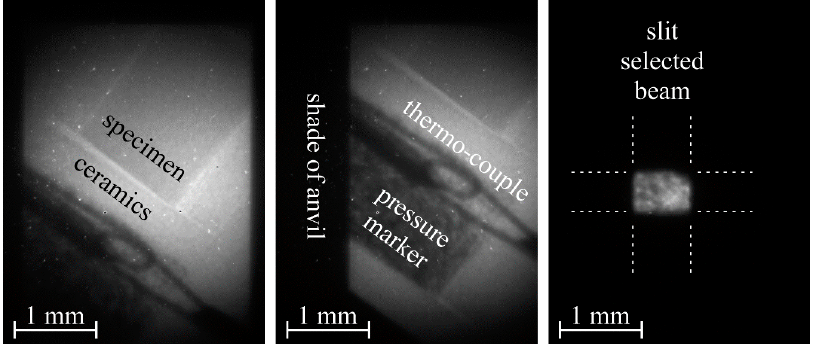
Figure 3. Typical radiographies of the pressure cell for sample alignment. The horizontal and vertical instrument axes show up and right in the figure. Translation of the entire apparatus with respect to the beam allows for different fields of view. The looped thermo-couple is a feature that can be well recognized in the left and central picture. To the right, beam size has been reduced to focus on a particular volume only, here the pressure